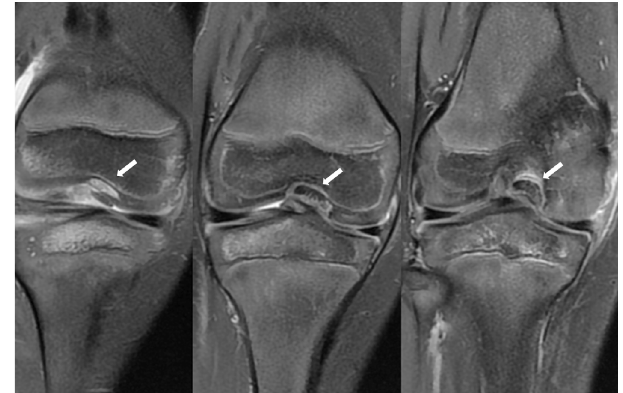
Figure 7. Case 2. First MRI with DP FS and coronal sequences. Cartilaginous nodule and “ nail-biting ” aspect in the medial part of the intercondylar notch (white arrows) was misdiagnosed. Figure 5. Case 2. Lateral view and sagittal sequences of second